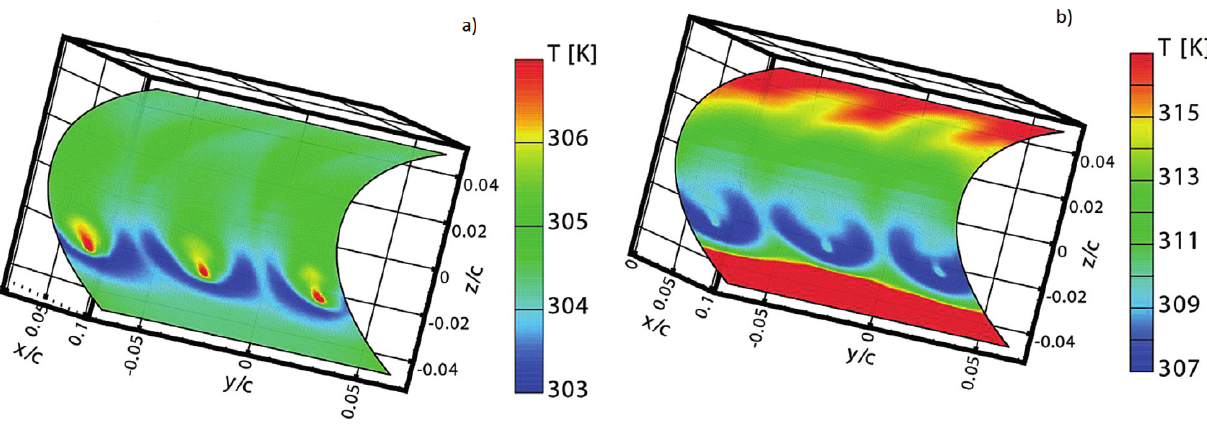
Figure 24. 3D temperature reconstruction for D = 4 mm, ϕ = 30°, M = 1.0 and p/D =